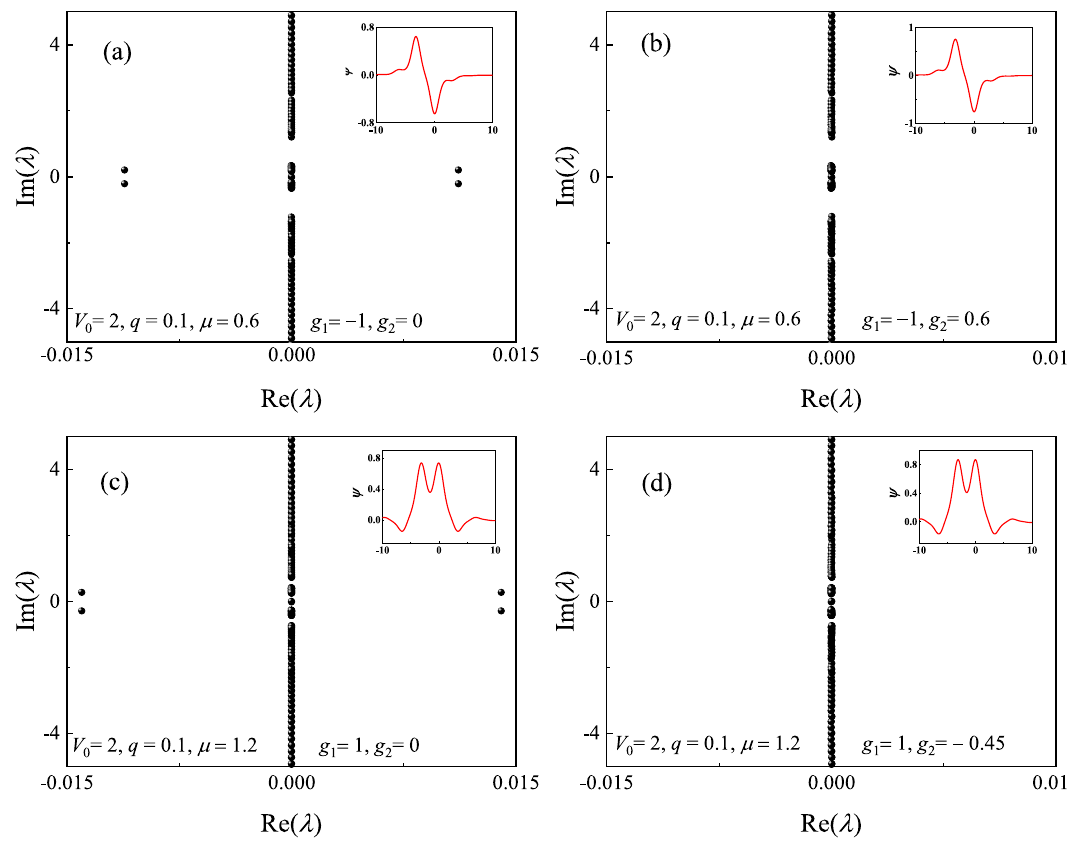
Figure 7. Stability spectra of gap solitons ( a , b ) in the semi-infinite gap and ( c , d ) in the first gap. The insets are the corresponding wave functions.